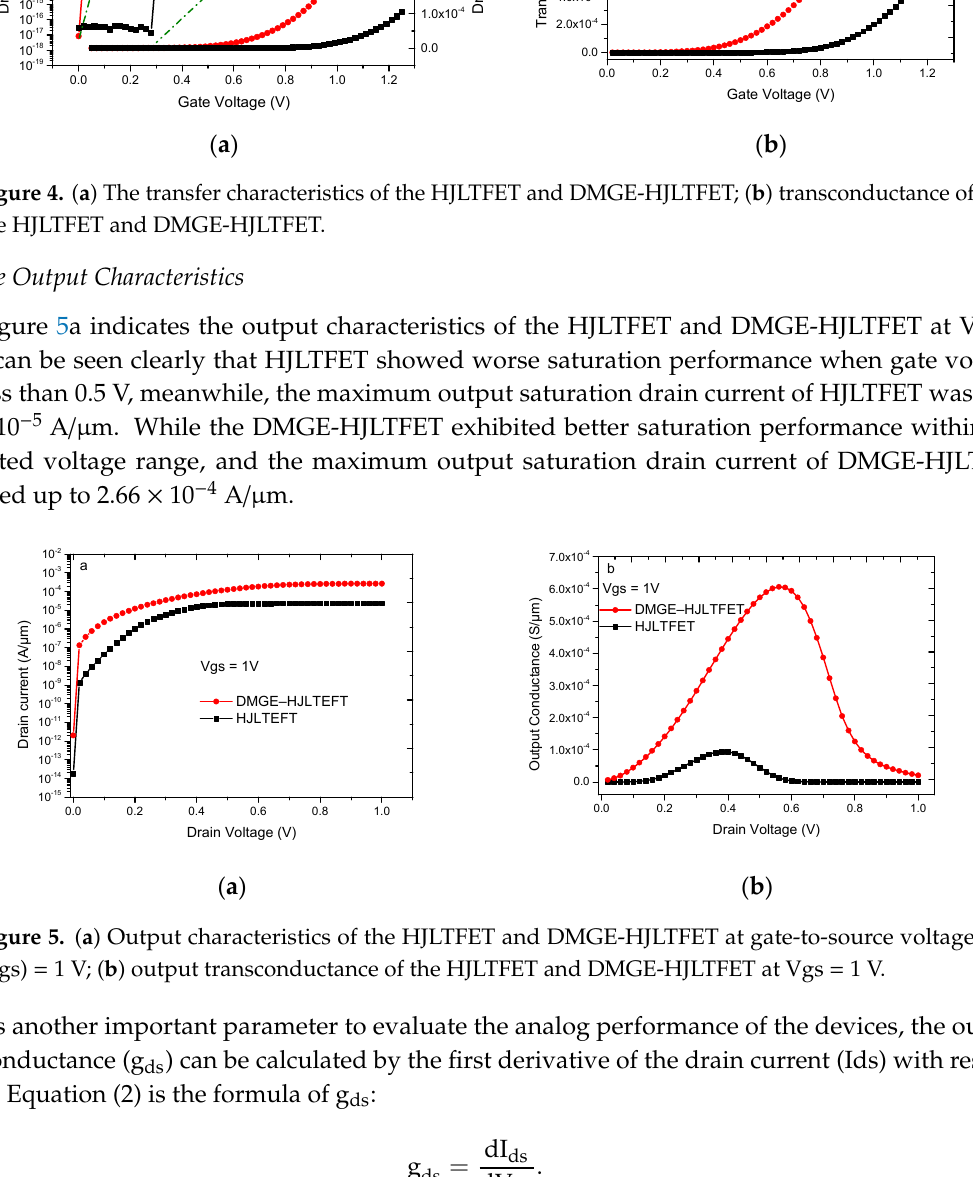
Figure 5. ( a ) Output characteristics of the HJLTFET and DMGE-HJLTFET at gate-to-source voltage (Vgs) = 1 V; ( b ) output transconductance of the HJLTFET and DMGE-HJLTFET at Vgs = 1 V.